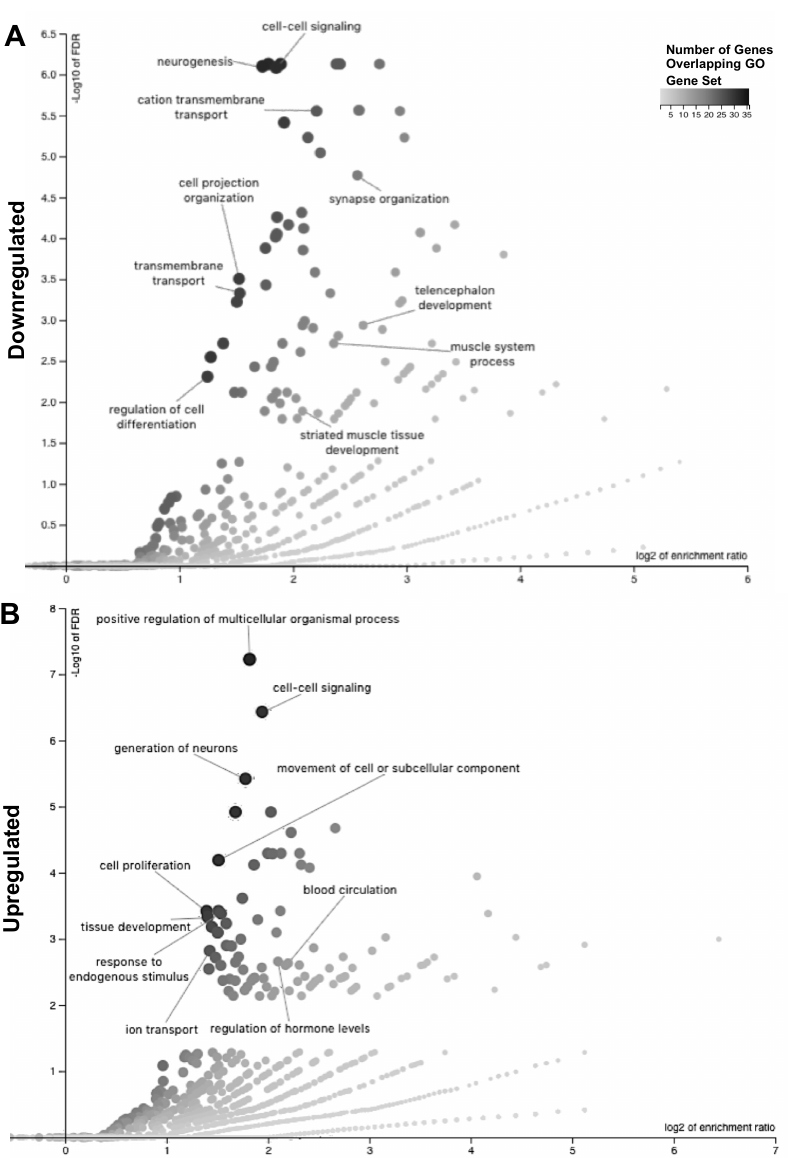
Figure 5. Altered biological processes and pathways identified at 4 months post-combined HLU + LDR exposure. ( A , B ) WebGestalt graphs depict enriched gene ontology (GO) terms for downregulated ( A ) and upregulated ( B ) DEGs. The x-axis measures the enrichment ratio for each GO term on a Log 2 scale. The y-axis measures -Log 10 (false discovery rate, FDR). The size and color tone of the dot is proportional to the size of the category. The displayed categories are from WebGestalt’s “Weighted set cover” option, which displays the GO categories that minimize redundancy.